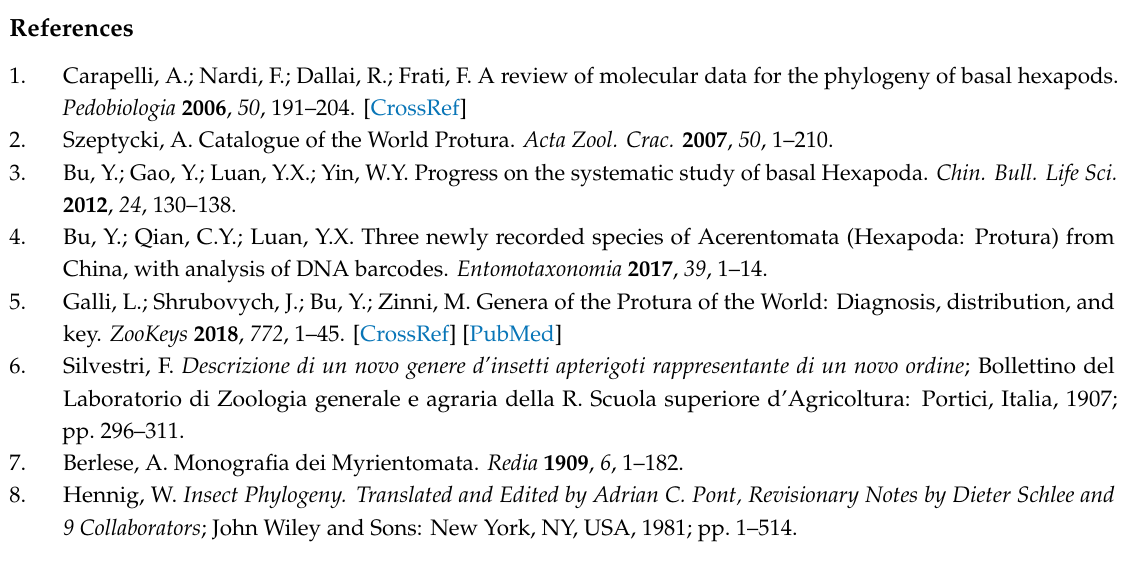
Figure S1: G + T vs. A + C content, calculated in a sliding window of 100 bp along the J-strand of the genomes of S. erythranum , A. muscorum and A. microrhinus . Genome maps are shown below each graph, Figure S2: Secondary structure of the 21 tRNAs detected in the mitochondrial genome of A. muscorum . The trnSgcu was not identified, Figure S3: Secondary structure of the 22 tRNAs detected in the mitochondrial genome of A. microrhinus , Figure S4: Phylogenetic analysis of Protura in the context of Arthropoda based on a subset of mitochondrial genes found in the same orientation. Posterior probabilities are shown above nodes. a: nucleotide dataset; b: amino acid dataset, model mixed; c: amino acid dataset, model MtPAN, Figure S5: Phylogenetic analysis of Protura based on the reduced 18S and 28S data set. Boostrap values shown at nodes, Table S1: List of species included in the phylogenetic analysis of Protura in the context of Arthropoda based on a subset of mitochondrial genes found in the same orientation. GenBank accession numbers are shown, Table S2: List of species included in the phylogenetic analysis of Protura based on cox1 , 18S and 28S concatenated sequences. GenBank accession numbers are shown, Table S3: Species delimitation analysis ( cox1 ). First column lists species as morphologically defined following BOLD or GenBank annotations. Second column reports BOLD identifiers for each specimen or GenBank accession for sequences not present in BOLD; specimens sharing the same cox1 haplotype (after alignment trimming) are grouped using thin horizontal lines. Columns 3 to 9 show results of di ff erent analyses for species delimitation; an open cell indicate a cluster of the corresponding specimens listed in the second column; open cells carry a numerical indication of the corresponding sublineage (for cross table reference) and (where applicable) statistical support for the group expressed as posterior probabilities. Open cells with an asterisk indicate alternative clusters with similar support. Grey shading highlights morphological species that have been subdivided in two or more sublineages by at least one species delimitation